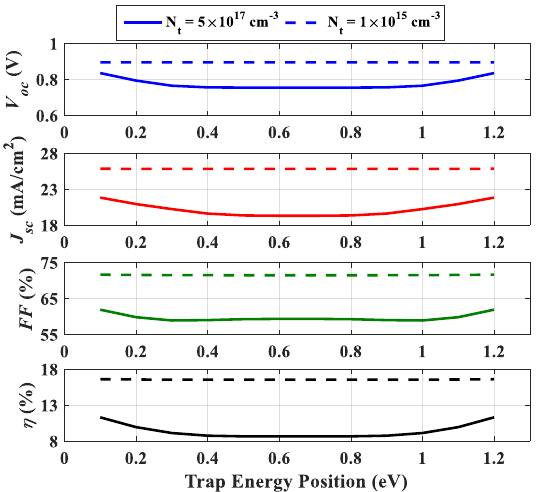
Figure 15. The HTL-free configuration photovoltaic parameters with various defect density ( N t ) in both n-CH 3 NH 3 SnI 3 and p-CH 3 NH 3 SnI 3.